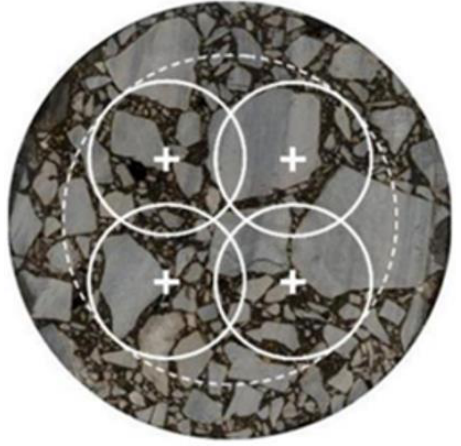
Figure 2. Thermal parameter test points of specimen.